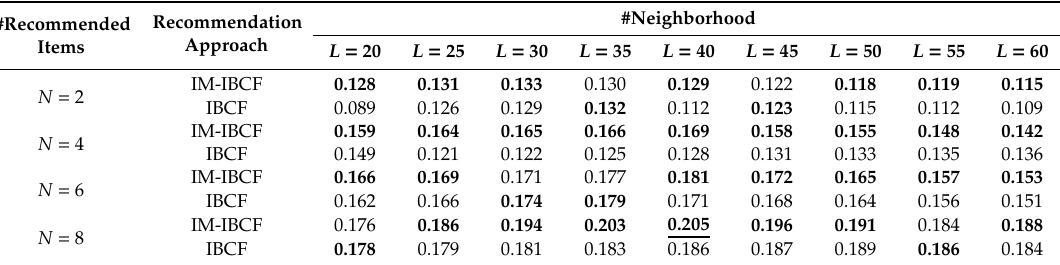
Table 9. Results of recall measure on the MovieLens 1M dataset.